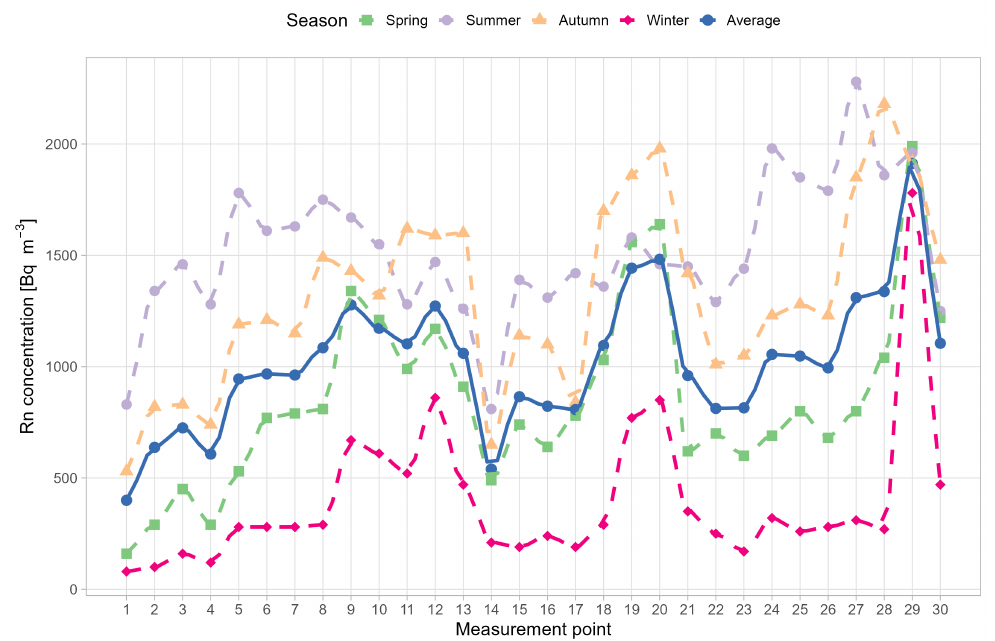
Figure 4. Seasonal variability of radon concentrations in four measurement seasons with average radon concentration (solid line) at 30 measurement